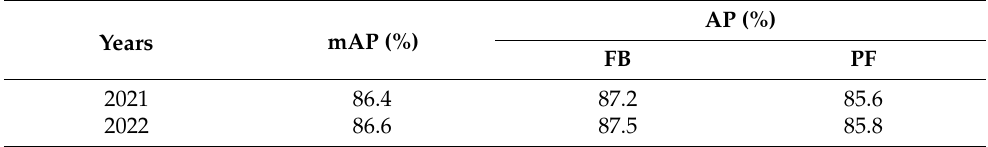
Table 3. Results of evaluating the generalizability of flower detectors across years.